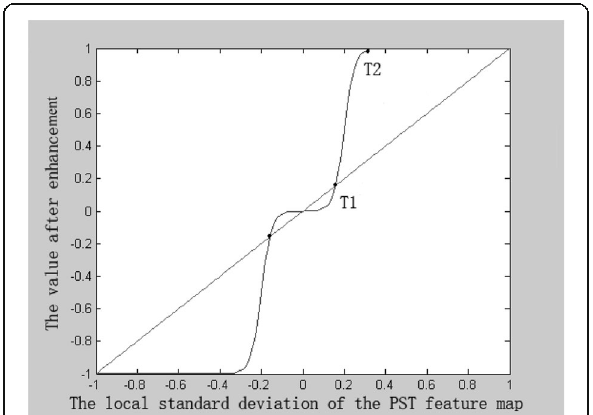
Fig. 2 The nonlinear enhancement